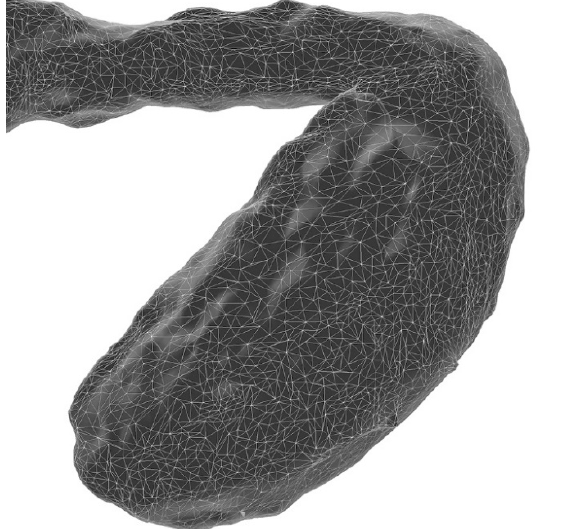
Figure 8. Detail of antenna of the 3D insect model illustrating the level of detail attained (~ 0.04 mm).